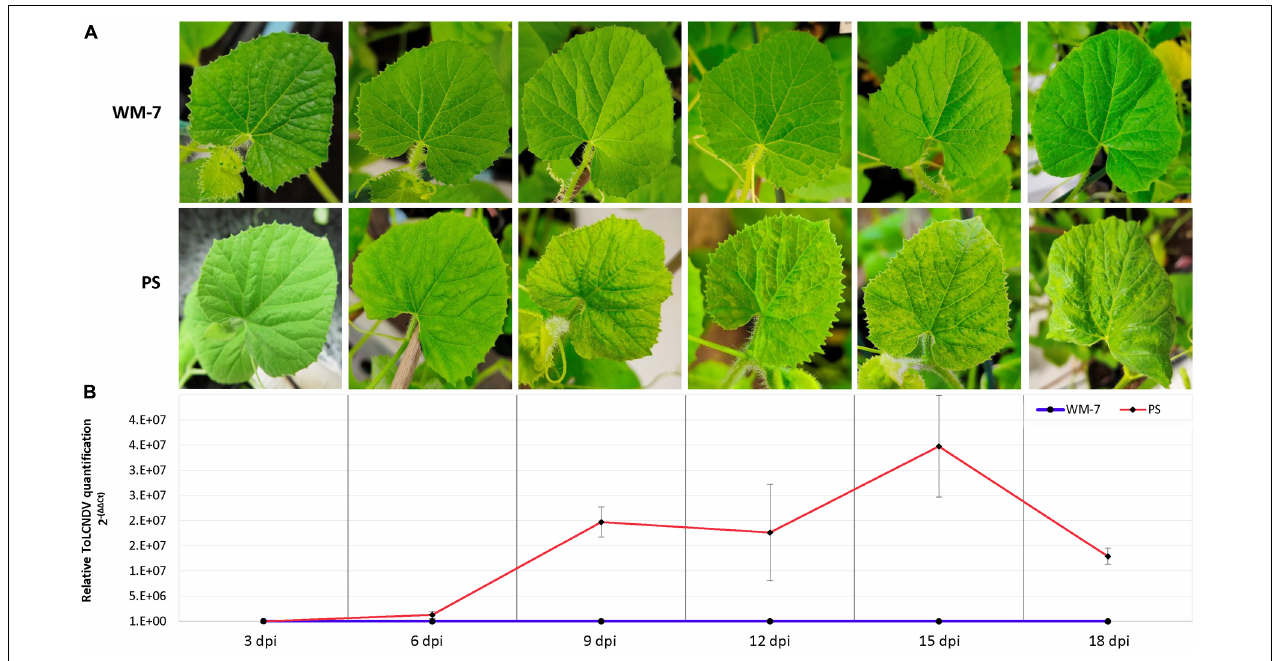
FIGURE 1 | Assessment of WM-7 and PS response to ToLCNDV-ES infection in the first total expanded apical leaf of each plant. Temporal evolution of symptomatology (A) and mean of viral titers (B) in WM-7 and PS.